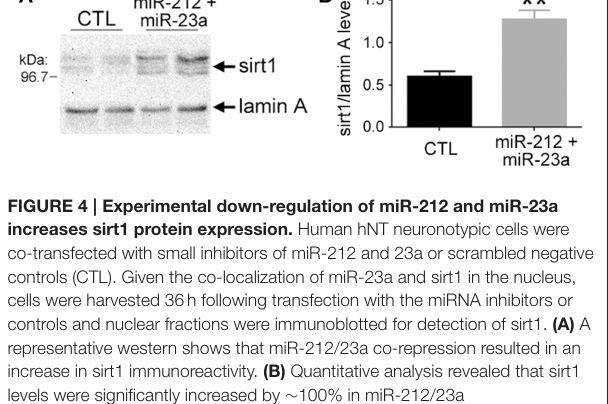
FIGURE 5 | Experimental down-regulation of miR-212 and miR-23a protects against A β 1 − 42 in a sirt1-dependent manner. Human hNT neuronotypic cells were co-transfected with small inhibitors of miR-212 and 23a or scrambled negative controls (CTL). Cells were then treated with 10 µ M A β 1 − 42 for 48h in the presence or absence of 100nM EX527, a sirt1-specific inhibitor, followed by incubation with propidium iodide (PI) as an assay for cell death. Bar graph shows that A β 1 − 42 treatment resulted in significant cell death that was significantly reduced by miR-212/23a co-repression. This rescue effect was reversed by EX527, suggesting that the protective effects of miR-212/23a co-repression was mediated by sirt1. n = 8 /group; * p < 0.05 vs. CTL; ** p < 0.05 vs. A β 1 − 42 via One-way ANOVA with Bonferroni correction for multiple